Question: State the chart type depicted above.
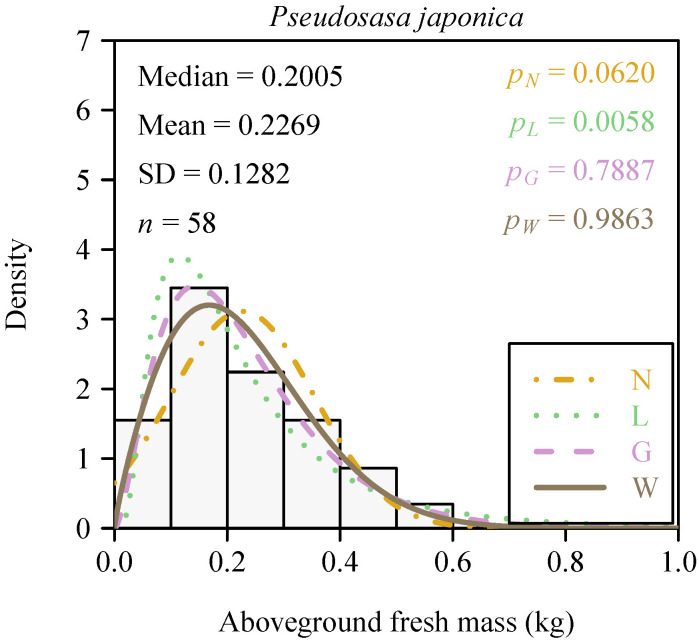
Answer: line